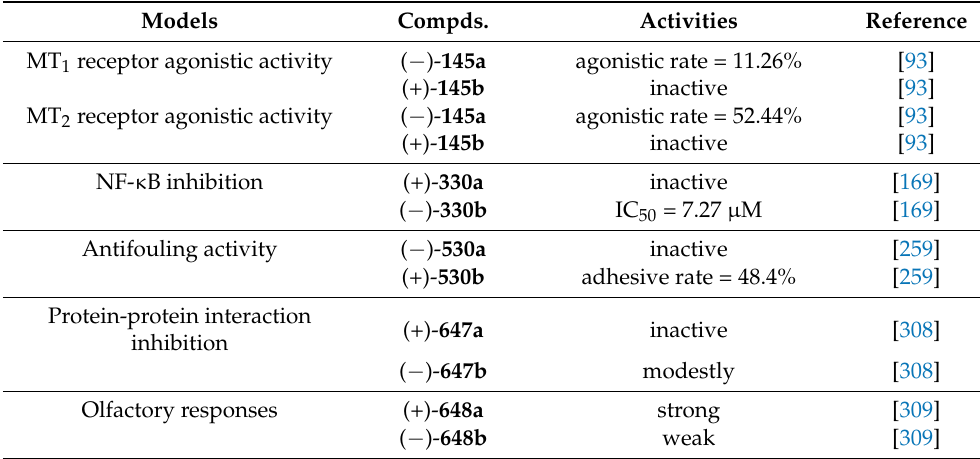
Table 11. Miscellaneous activities of